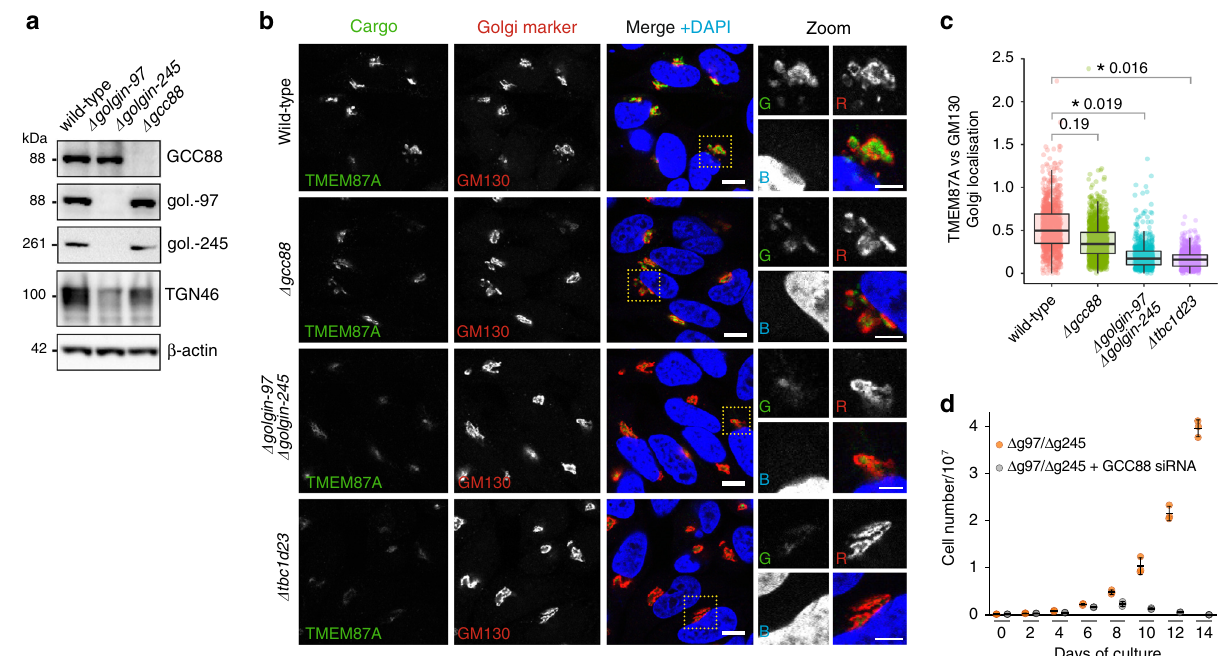
Fig. 6 GCC88 and golgin-97/golgin-245 have redundant roles that together support cell viability. a Immunoblot of proteins from wild-type and mutant HeLa cells probed with antibodies against the indicated proteins, blot representative of two independent experiments. b Confocal micrographs of wild-type and mutant HeLa cells stained for endogenous TMEM87A (cargo), GM130 (marker of cis -Golgi) and DAPI. Micrographs representative of three independent experiments, scale bars, 10 μ m (5 μ m in zoom). c Quanti fi cation of b measuring the ratio of the intensity of TMEM87A at the Golgi over that of GM130. Boxplots are of data from three independent replicates, n ≥ 300 per replicate, as for Fig. 1g. P -values are of two-sided two-sample t -tests comparing the means of ratios from the three replicates for each cell type. d Effect of knockdown of GCC88 on growth of Δ golgin-97 / Δ golgin-245 double knockout HeLa cells - three replicates per time point (error bars show mean and SD). Data are provided as a Source Data fi